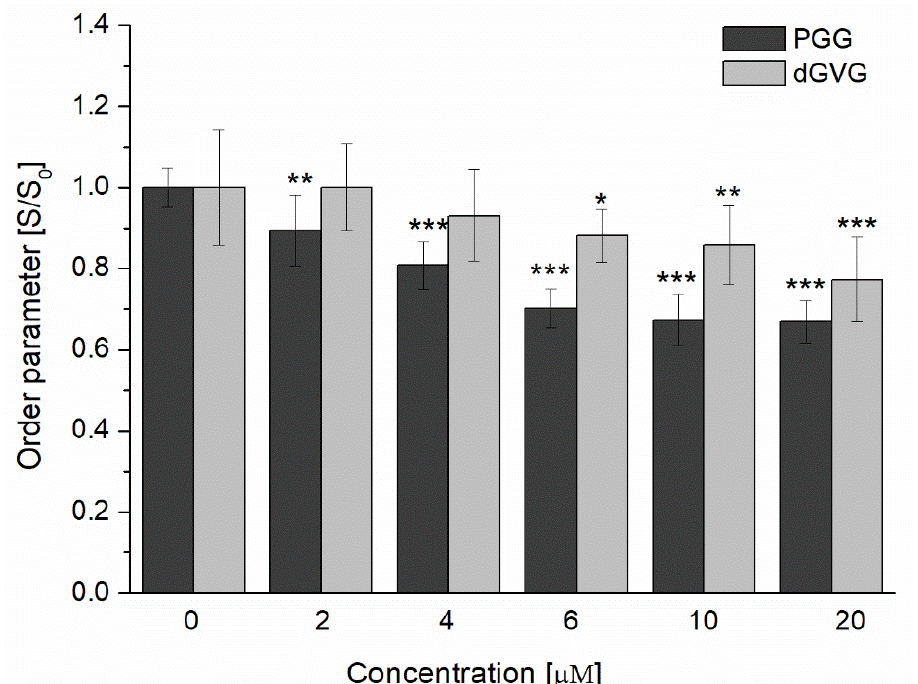
Figure 4. Changes in the order parameter S/S 0 of the S. aureus membrane measured using a TMA- DPH probe in the presence of PGG and dGVG. The data presented are the means ± SD, n = 6. Statistical significance was estimated using a one-way ANOVA test (results compared to control, * p < 0.05; ** p < 0.01; *** p < 0.001).